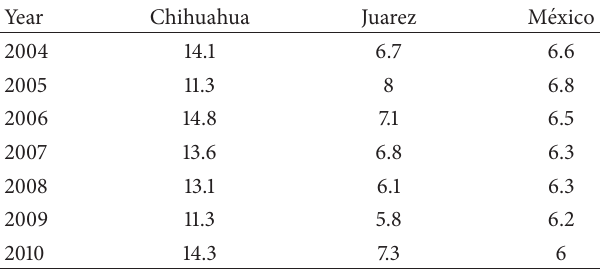
Table 1: LC mortality rates of Chihuahua City, Ciudad Juarez, and M´exico.